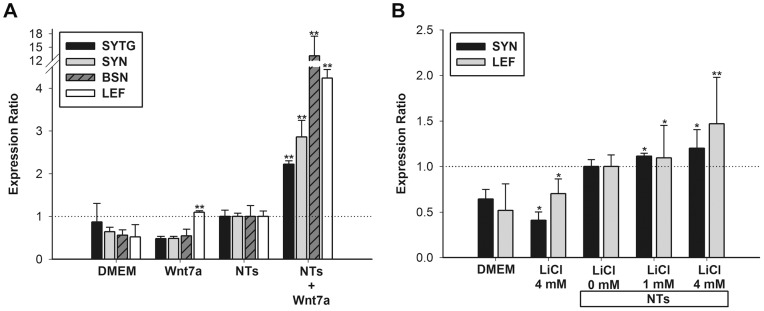
Induction of synaptic markers by Wnt7a and lithium in NT-stimulated hMSCs.(A) Wnt7a groups were treated with Wnt7a (2 µg/ml) for 2 days, and the NTs groups were treated with NTs for 9 days. After NTs treatment for 1 week, Wnt7a (2 µg/ml) was added to the NTs+Wnt7a groups for 2 days. mRNA levels of LEF1, SYN1, BSN, and SYTG were examined in hMSCs, and levels were normalized to those in the NTs control (set to 1.0). Wnt7a induced mRNA expressions of SYN1, BSN, and SYTG in NT-stimulated hMSCs, and this induction was related to upregulation of LEF1. Data are presented as the mean ± SD of one triplicate experiment that was representative of three independent experiments. * p<0.05, ** p<0.01 (NTs and Wnt7a vs. DMEM; NTs+Wnt7a vs. NTs). (B) LiCl groups were treated with LiCl (4 mM) for 2 days, and NTs groups were treated with NTs for 9 days. After NTs treatment for 1 week, LiCl (1 or 4 mM) was added to the NTs+LiCl groups for 2 days, mRNA levels of SYN1 and LEF1 were examined in hMSCs, and their levels were normalized to those in the DMEM control (set to 1.0). * p<0.05, ** p<0.01 (NTs and LiCl vs. DMEM; NTs+LiCl vs. NTs).